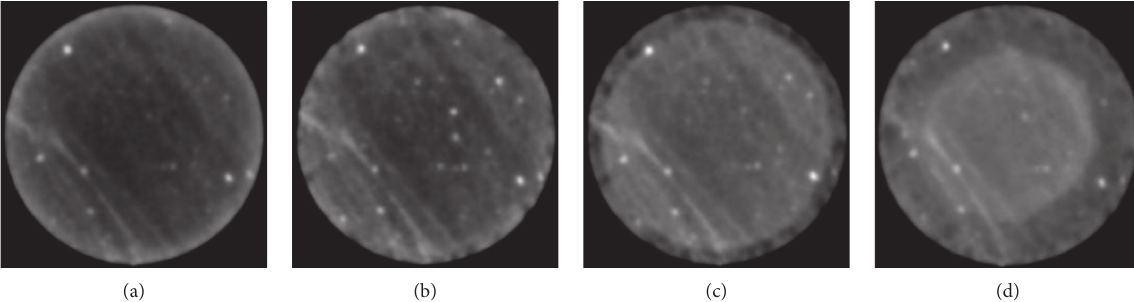
Figure 4: CTscanning image of the middle layer of rock sample after different corrosion times. (a) pH � 1 HCl (0d). (b) pH � 1 HCl (30